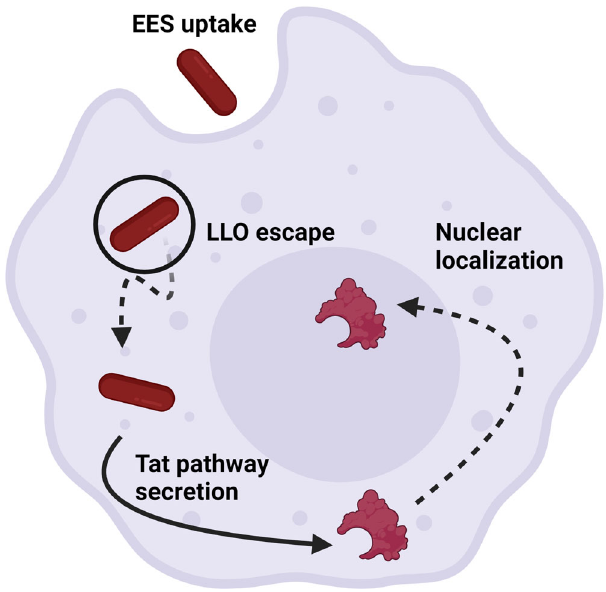
Fig. 1 EES as a means of controlling gene expression in mammalian host cells. The EES enter phagocytic mammalian host cells and escape the phagosome using the LLO protein. The EES then secrete a reporter protein or transcription factor into the cytoplasm through the Tat pathway followed by localization to the host cell nuclei. Expression of mammalian transcription factors from the EES were shown to direct macrophage